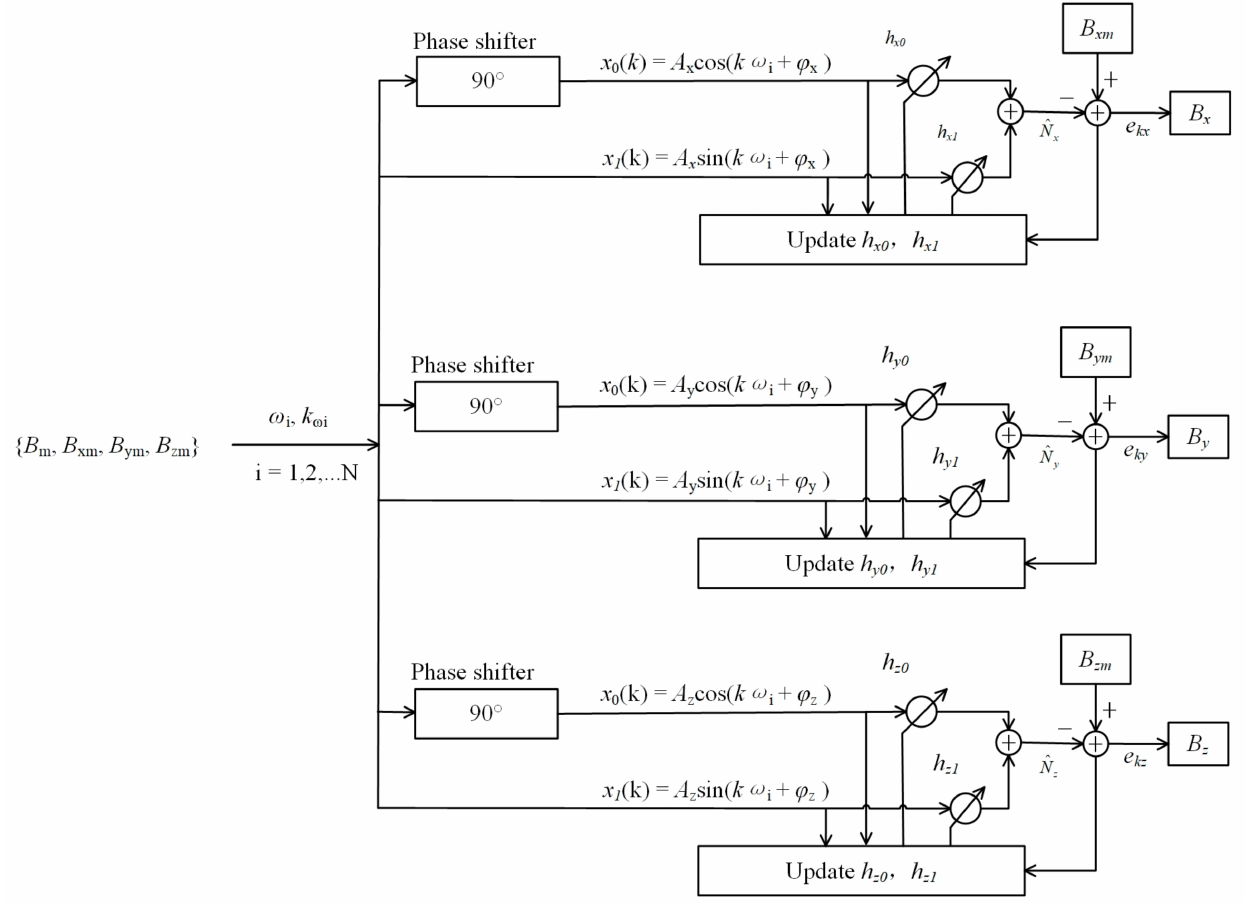
Figure 3. Schematic diagram of the triaxial adaptive notch